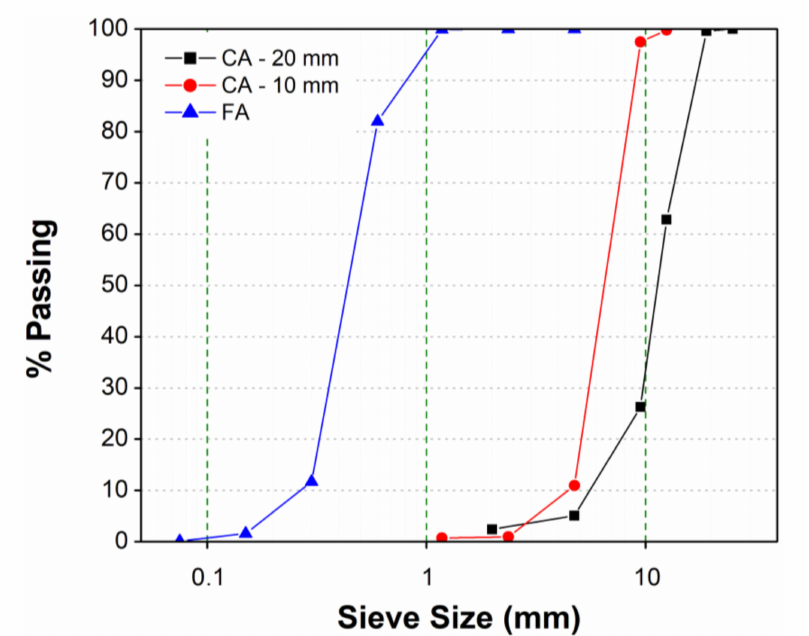
Figure 3. Particle size distribution of fine and coarse